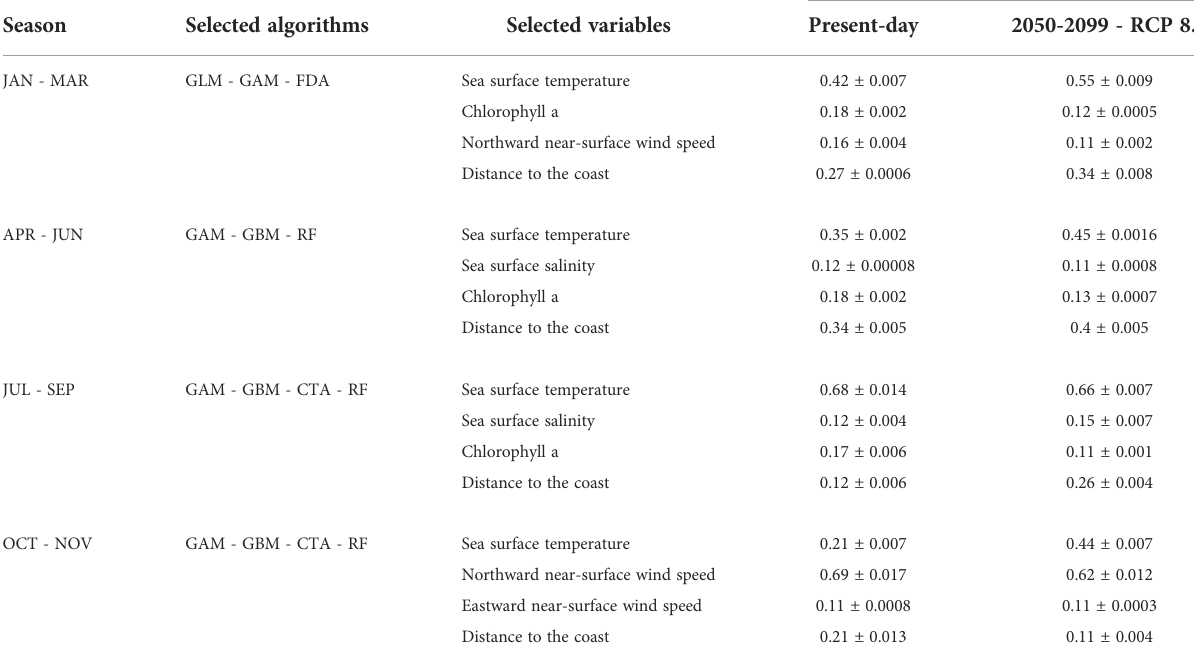
TABLE 1 Selected algorithms and variable importance of each season for the present-day and future